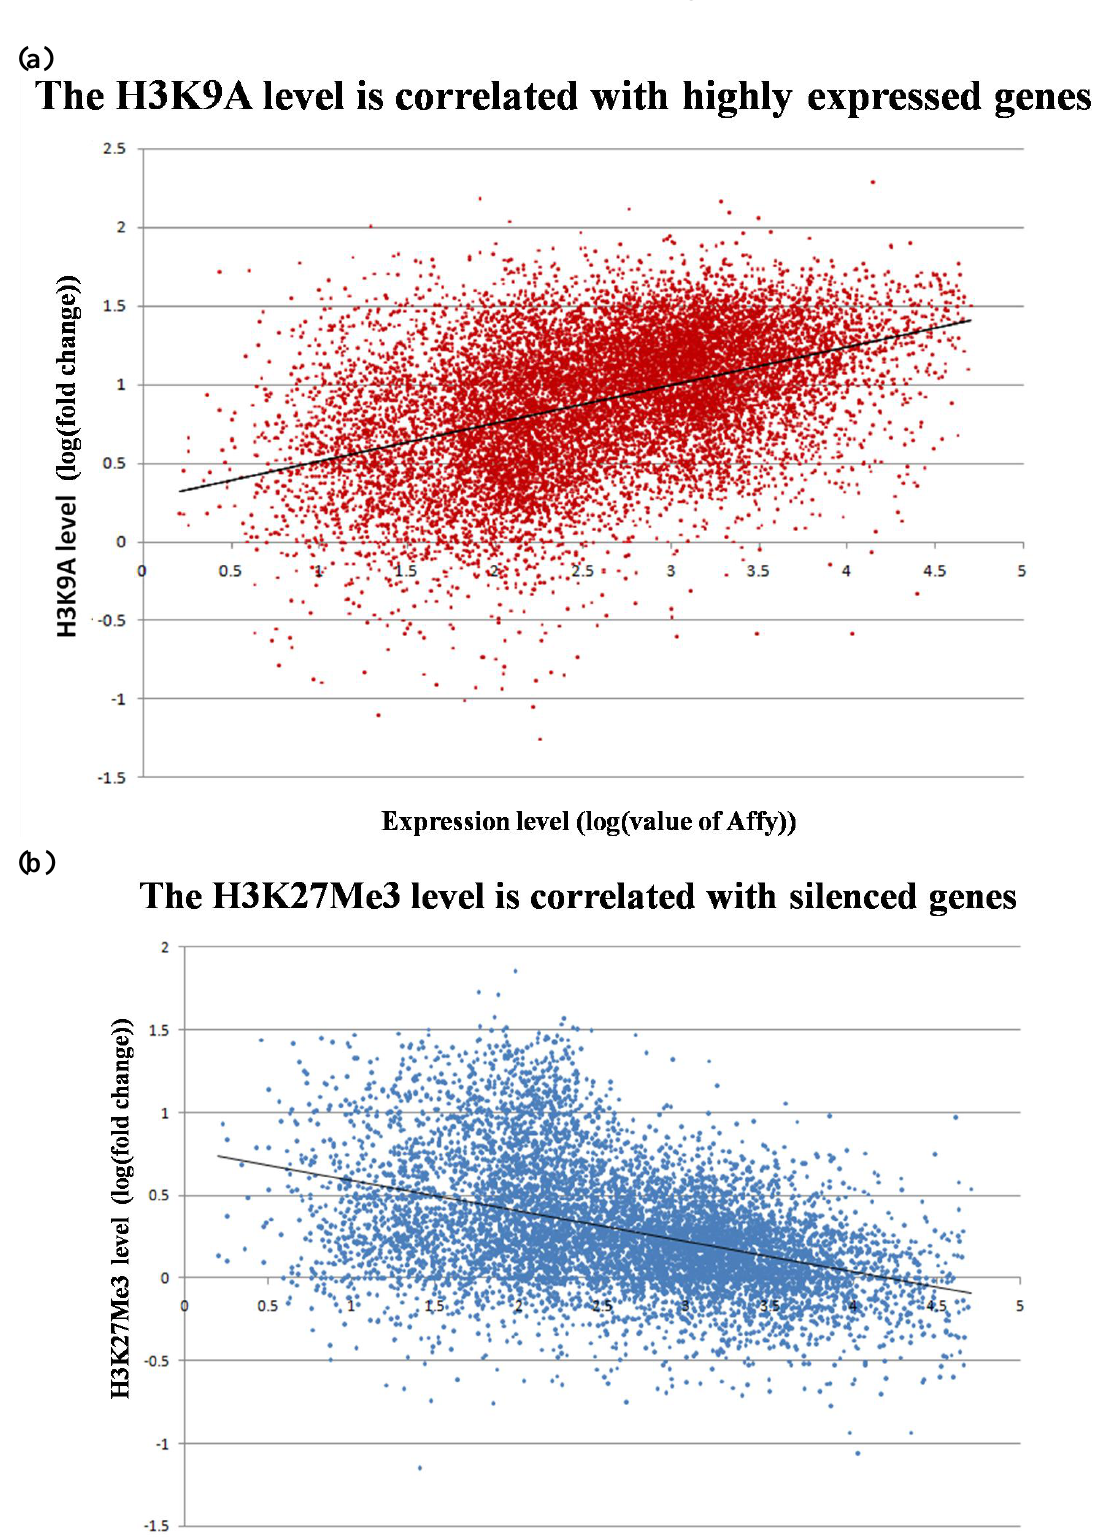
Figure 7. Correlation between histone modification and gene expression. Gene expression data are from a microarray analysis. (a) Positive correlation between H3K9Ac modification and gene expression (r = 0.546; p < 0.01); (b) Negative correlation between H3K27Me3 modification and gene expression (r = −0.368; p < 0.01). Statistical analysis and Pearson correlation coefficient was carried out using